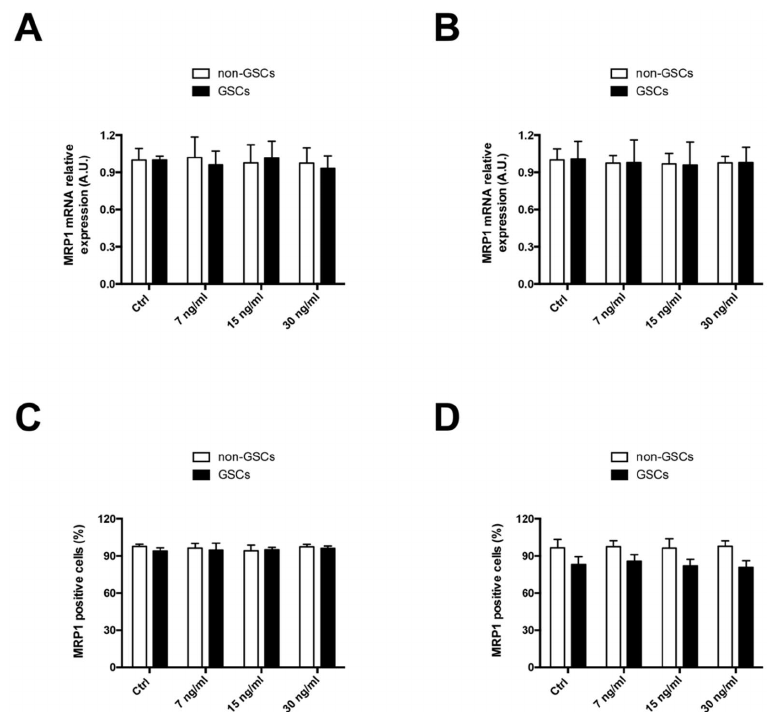
Figure 1. Effect of Tacrolimus (FK506) on multidrug resistance-associated protein 1 (MRP1) levels in U87MG and C6 cells. Cells were treated with FK506 (7, 15, and 30 ng/mL) for 24 h. MRP1 mRNA levels were measured by RT-qPCR in U87MG cells ( A ) and C6 cells ( B ). Graphs represent the values normalized by actin beta (ACTB). MRP1-positive cells were quantified by flow cytometry in U87MG cells ( C ) and C6 cells ( D ). White bars represent non-glioblastoma stem-like cells (GSCs) and black bars represent glioblastoma stem-like cells (GSCs).